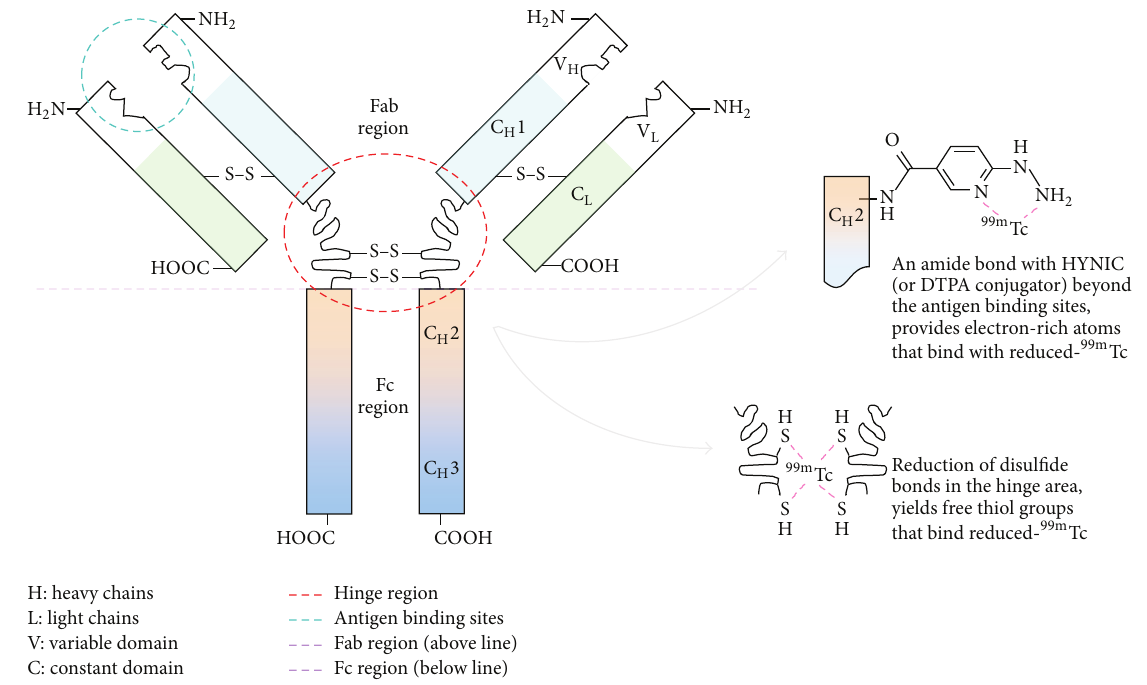
Figure 4: An annotated diagram of IgG depicting the antigen binding sites and isotope binding